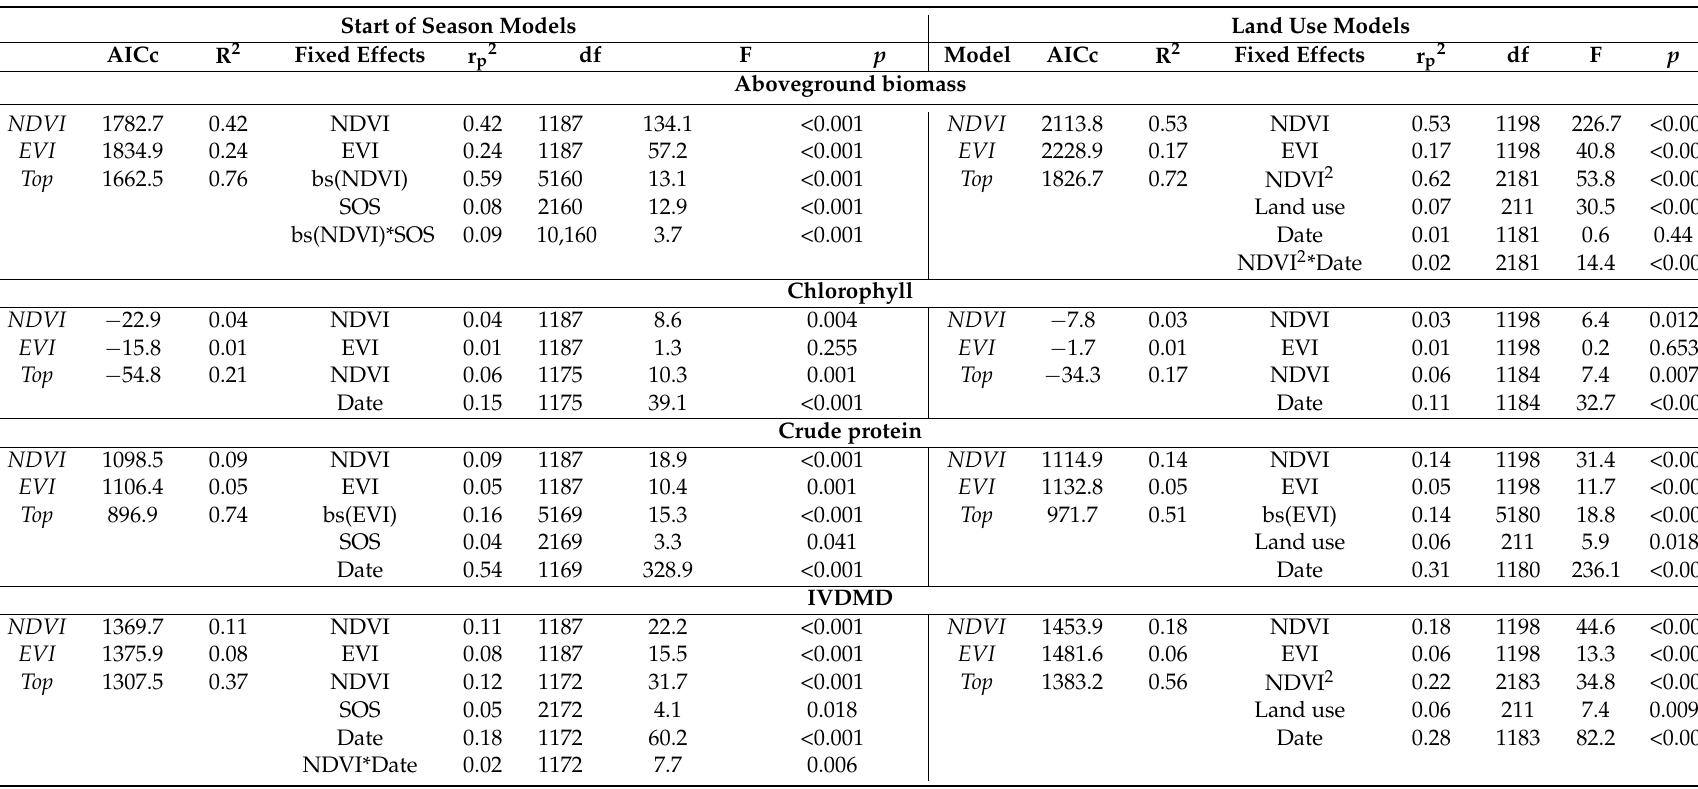
Table 1. Statistics from the linear NDVI, linear EVI, and top models of biomass, chlorophyll, crude protein, IVDMD in the start of season (SOS) and land use classes. Model statistics include the corrected AIC (AIC c ), the adjusted R 2 from the NDVI and EVI models, the marginal R 2 [57] from the top models, the partial R 2 , the F-statistics, and the p